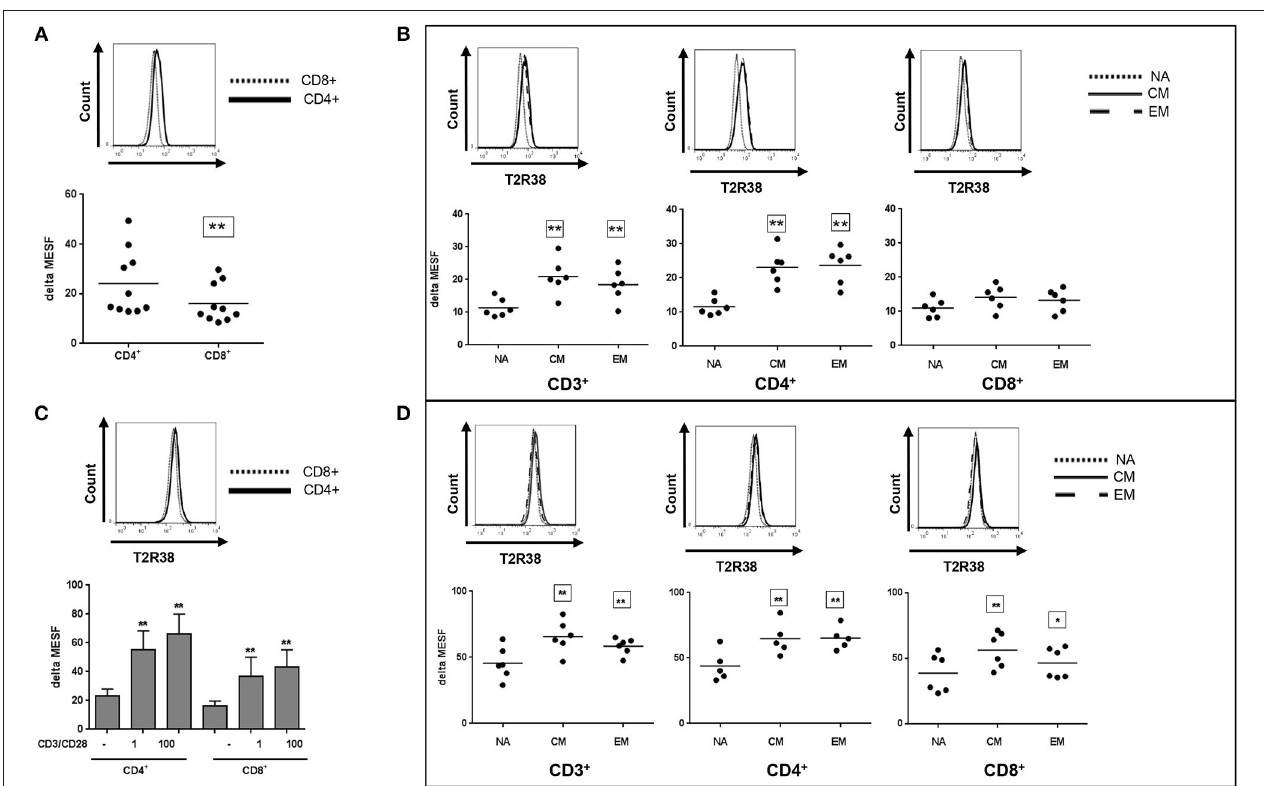
FIGURE 3 | T2R38 expression status in T cell subsets. T2R38 expression was quantified in (A,B) freshly isolated cells ( n ≥ 6) or (C,D) CD3/CD28-stimulated cells after 72h ( n ≥ 5). Each dot represents one donor, bars are means + SD . NA, naïve, CM, central memory, EM, effector memory cells. Representative histograms of different stains from one donor are shown. The gating strategy is given in Supplementary Figure S3 . T2R38 expression (delta MESF) was assessed by Quantum Alexa Fluor 488 MESF beads in comparison to rabbit IgG isotype control. Significance of difference was calculated relatively to the respective control, * p < 0.05, ** p <